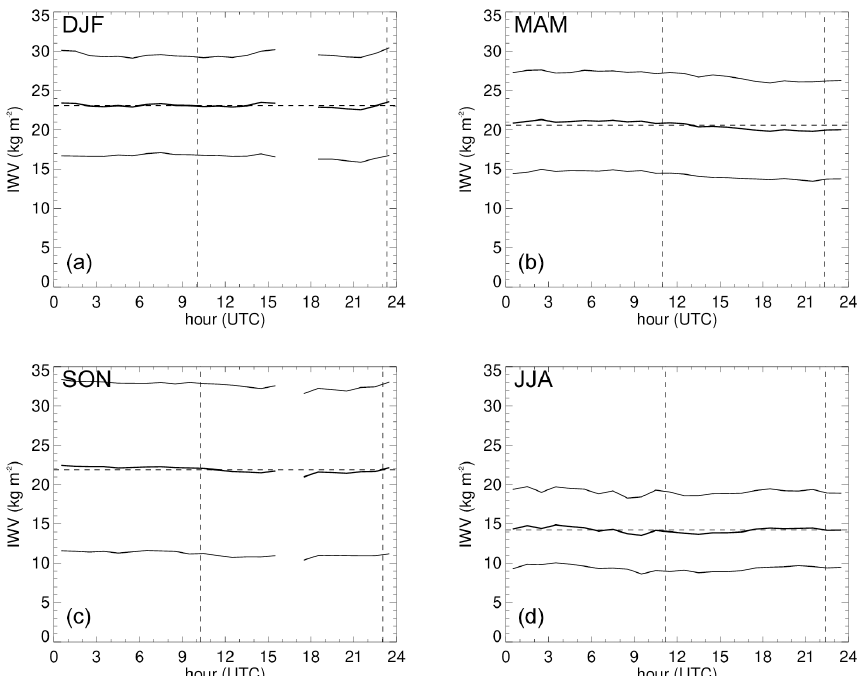
Figure 16. Average diurnal course of column integrated water vapor (IWV) during different seasons (thick line) plus or minus its standard deviation (thin lines) as a measure for day-to-day variability. Clockwise: (a) austral summer (DJF), (b) fall (MAM), (d) winter (JJA) and (c) spring (SON). Vertical dashed lines indicate the average times of sunrise and sunset. The gap around 17:00UTC in austral summer (DJF) is due to times when the Sun is in zenith, making retrieval impossible.